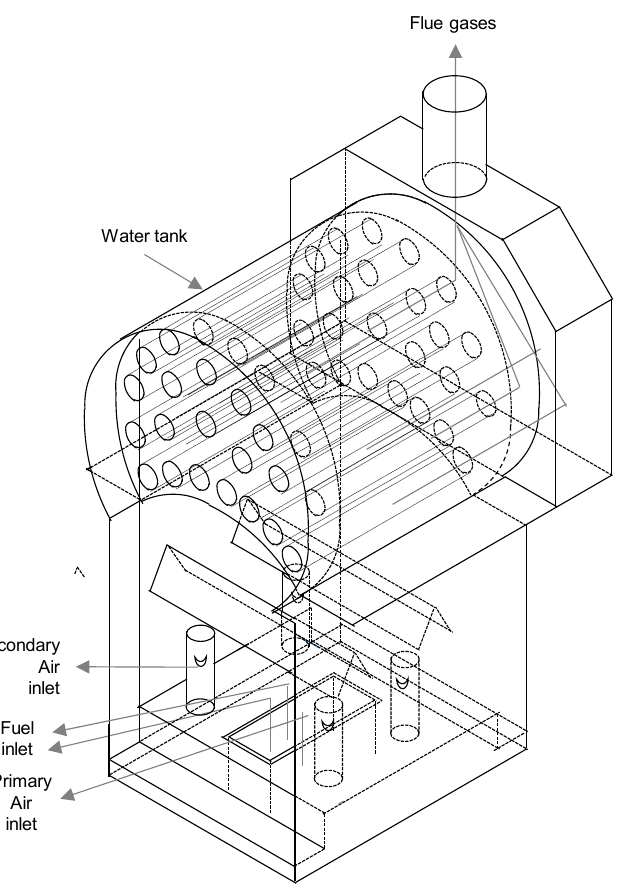
Figure A1. Schematic of the boiler’s internal design.